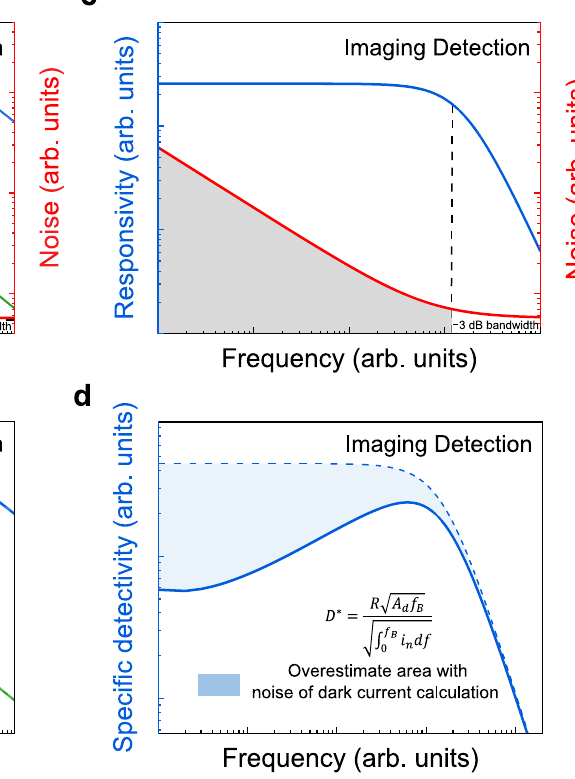
ffiffiffiffiffiffiffiffi p A d Δ f from the dashed lines present the calculated speci fi c detectivity with D * = R i n measured noiseand estimatednoiseofthermalnoiseand shotnoise (ignoringthe 1/ f noiseandg-rnoise). c Noiseandresponsivitycharacteristicsforphotodetectors of imaging detection. d Overestimation of speci fi c detectivity based on noise characteristics for imaging detection. The solid and dashed lines present the cal- ffiffiffiffiffiffiffiffi p A d f B ffiffiffiffiffiffiffiffiffiffiffiffiffi R q from the measured noise and esti- culated speci fi c detectivity with D * = R fB 0 i n df mated noise of thermal noise and shot noise (ignoring the 1/ f noise and g-r